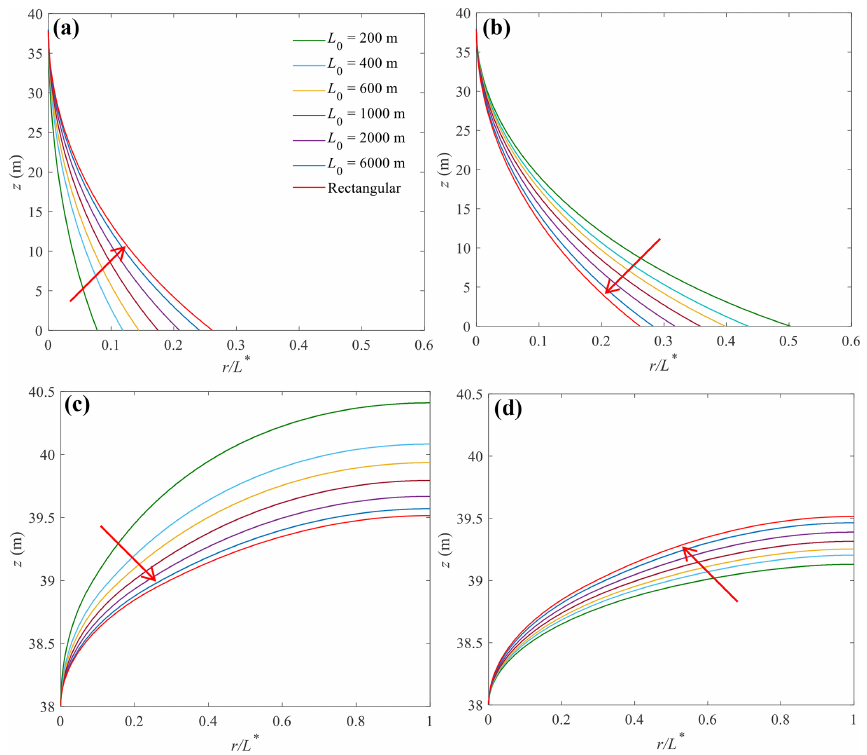
Figure 7. Sensitivity of (a, b) the locations of the freshwater–seawater interface and (c, d) watertable to L 0 for convergent (a, c) and divergent (b, d) aquifers. The arrow in each plot shows the direction of increasing L 0 (values given in a , used to produce the different curves). Note that predictions for rectangular aquifers are independent of L 0